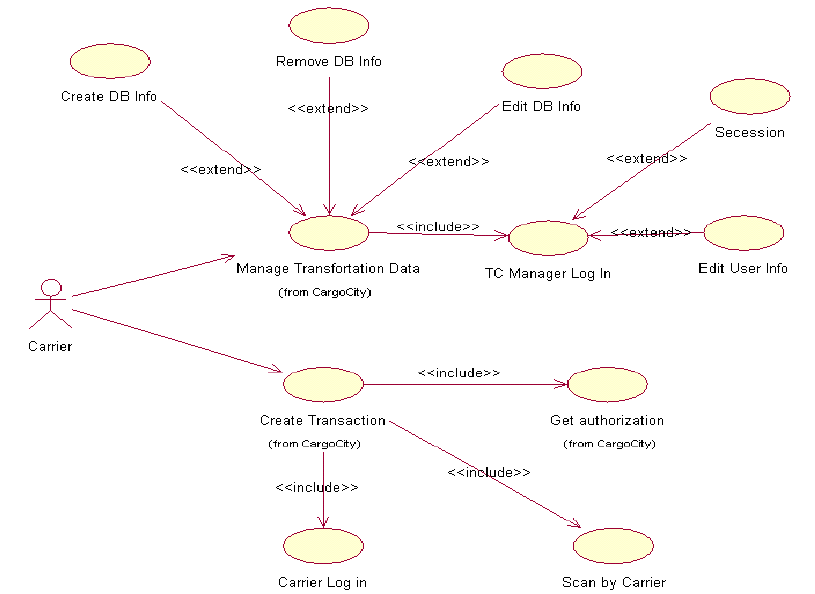
Figure 1. Use-case diagram shows the required activities of